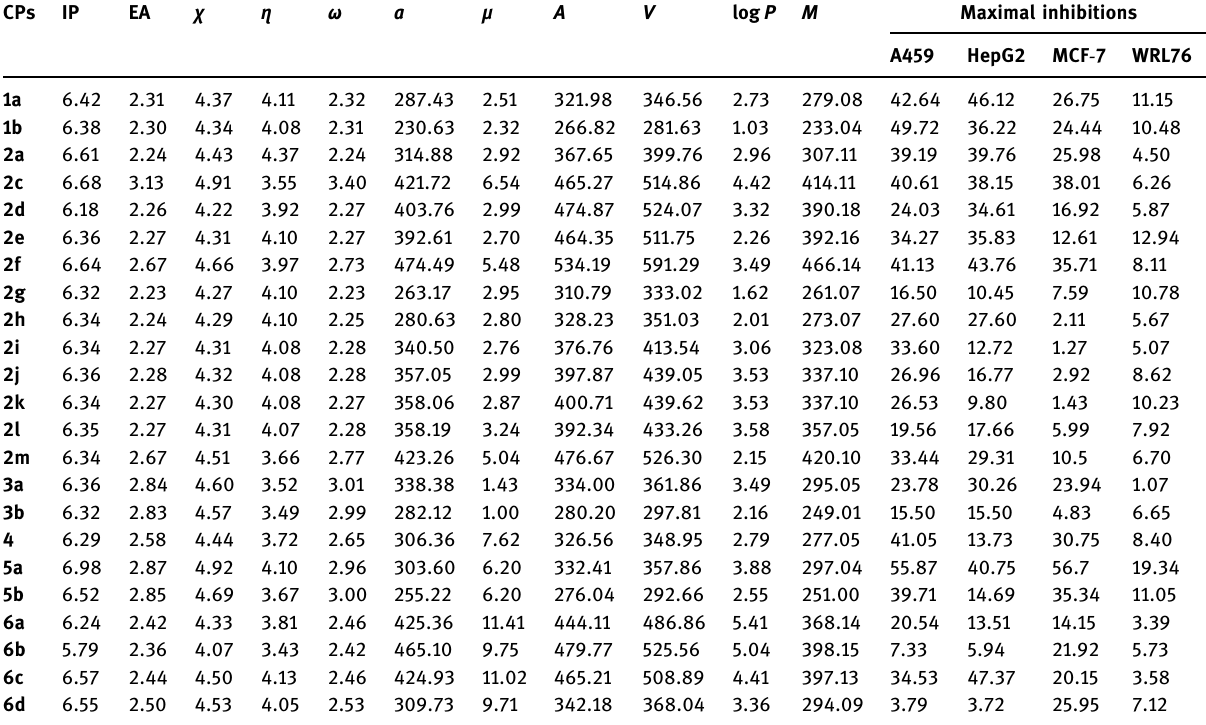
Table 3: Maximal percentage of cell viability at 200 µg/mL of samples against A549, HepG2, MCF - 7, and WRL68 cell lines and molecular descriptors calculated at B3LYP/6 - 31 + G ( d,p ) of the synthesized compounds